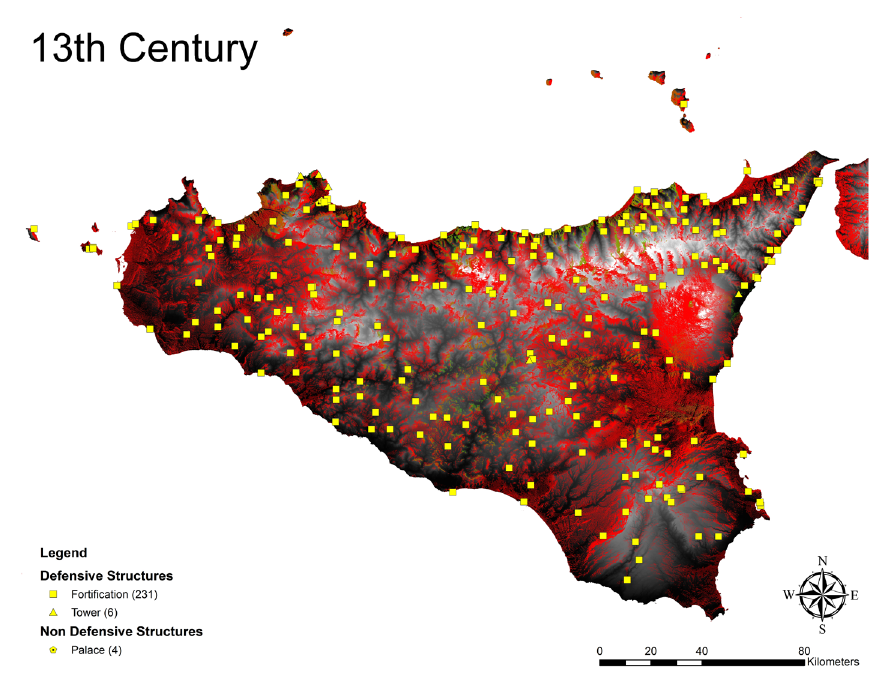
Figure 4. Figure showing the distribution of defensive structures and their viewsheds in the 13th century. Fortifications are represented by squares and the area they have surveillance over is in red whereas towers are represented by triangles and the area they have surveillance over is in green. Also included are palaces represented by hexagons. Image derived from an ASTER GDEM (a product of NASA and METI).